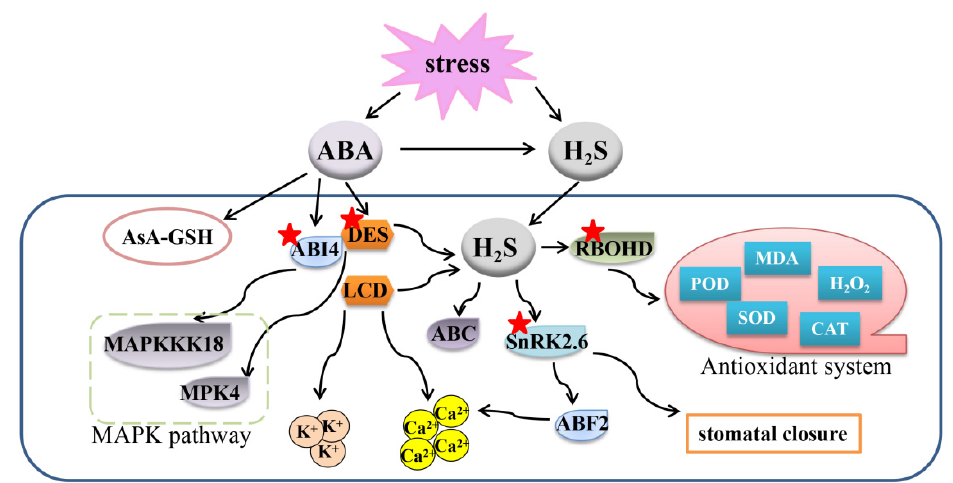
Figure 3. Overview of the mechanisms of the crosstalk between ABA and H 2 S to regulate plant response to abiotic stresses. A gene or protein marked with a red asterisk means that the protein can be persulfided. H 2 S, hydrogen sulfide; ABA, abscisic acid; ABF2, ABA response element-binding factor 2; AsA-GSH, ascorbate-glutathione cycle; SnRK2.6, snf1-related protein kinase 2.6; RBOHD, respiratory burst oxidase homolog protein d; MDA, malondialdehyde, ABI4, abscisic acid insensitive 4; MAPK, mitogen-activated protein kinase.